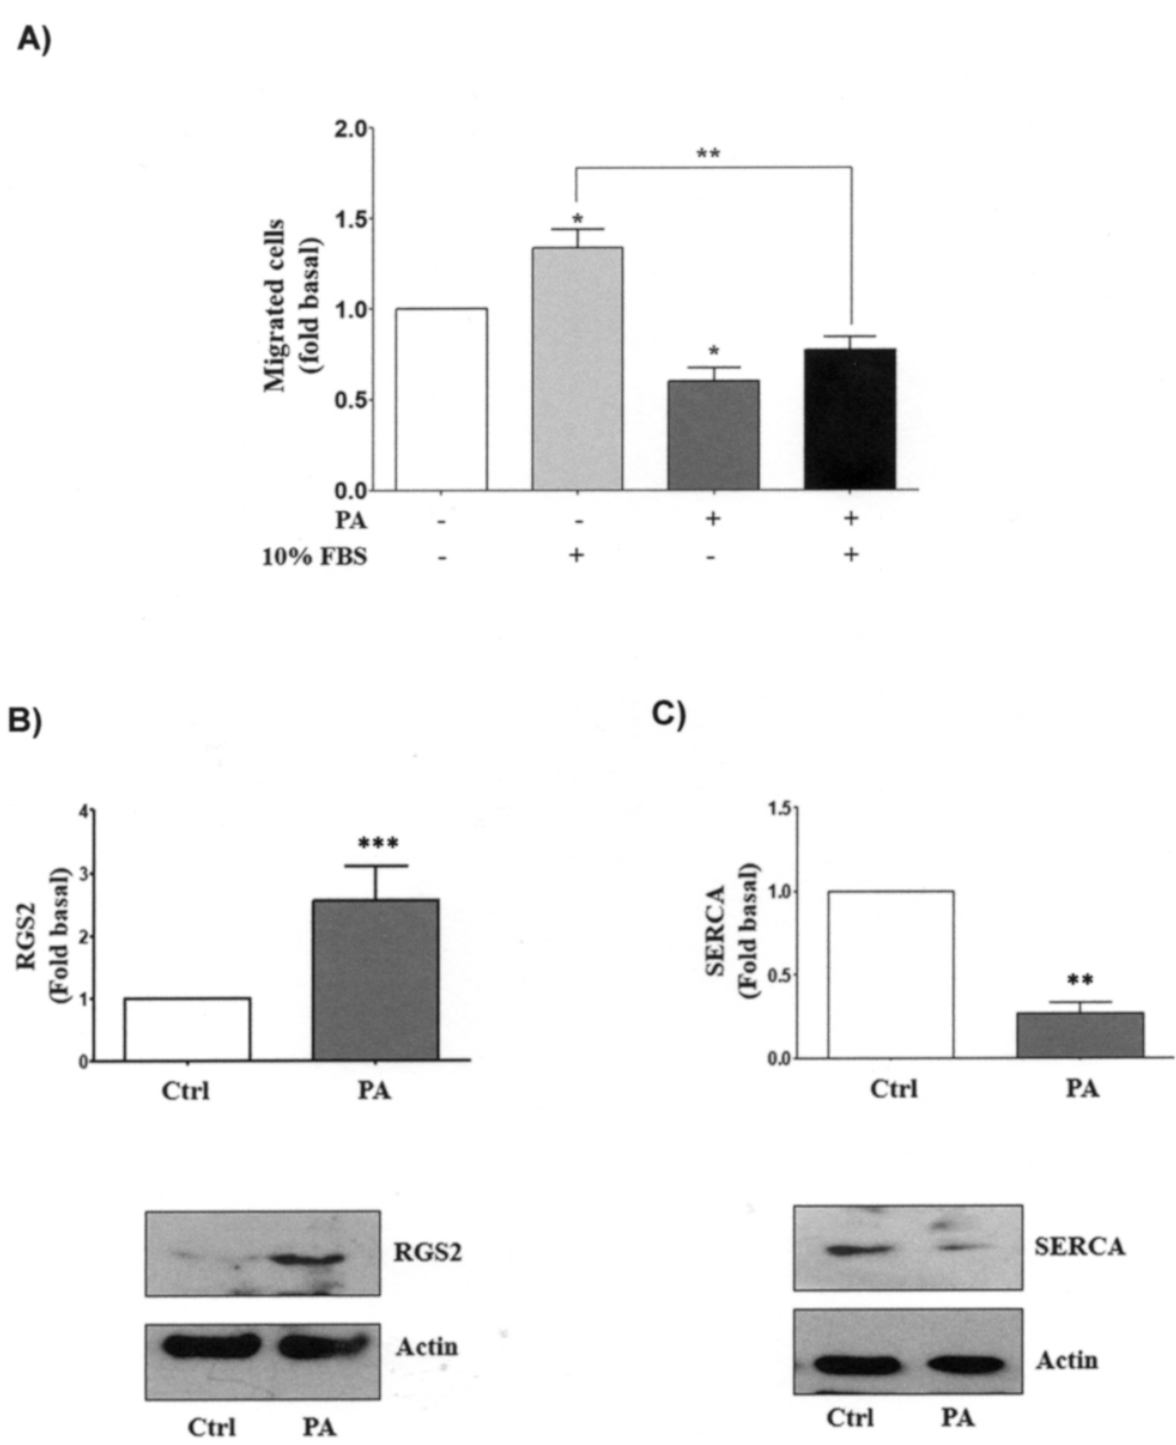
Figure 1 – Palmitic acid inhibits cell migration in HEK293 cells. a . After starvation, HEK293 cells were washed, equilibrated in DMEM without FBS, and pretreated for 2 h with 12 μM mitomycin C. Cells were untreated or treated with 0.25 mM PA (an inducer of cell migration) or 10% FBS and cell migration assays were performed by using the Boyden chamber method. The graphs represent the mean ± S.E.M. of migration of three independent experiments and are expressed as the fold of unstimulated cells. b , c After starvation, HEK293 cells were washed and equilibrated in DMEM without FBS. Cells were treated with 0.25 mM PA in DMEM and lysates were obtained. RGS2 and SERCA were analyzed by western blotting with anti-RGS2 and anti-SERCA2, respectively. Western blots were also probed for actin as a loading control. Asterisks denote comparisons made to unstimulated cells. * p <0.05, ** p <0.01, *** p <0.001 vs control condition (unstimulated cells).